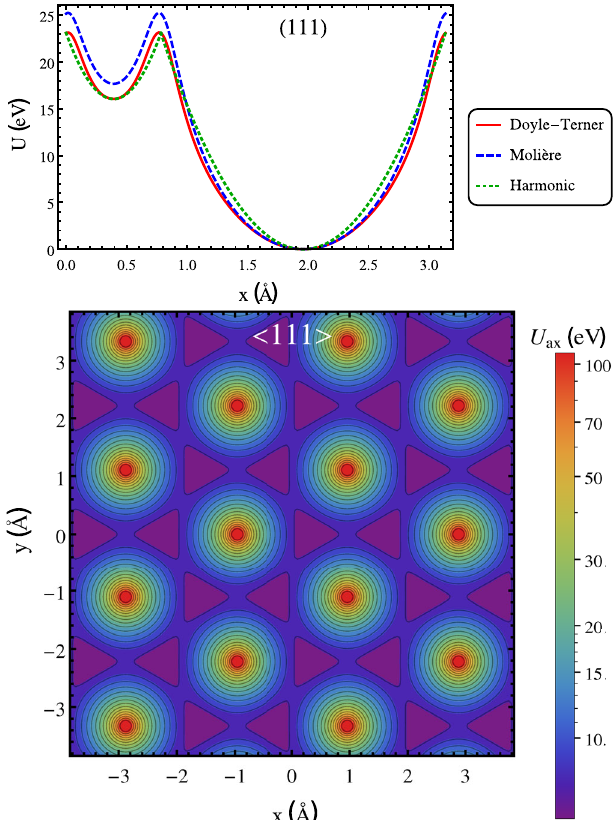
FIG. 1. Averaged potential examples. Top: interplanar potential in a silicon crystal between (111) crystal planes, calculated in the models of the harmonic, Moli`ere and Doyle-Terner potentials. Bottom: interaxial potential in a silicon crystal between h 111 i crystal axes in the model of